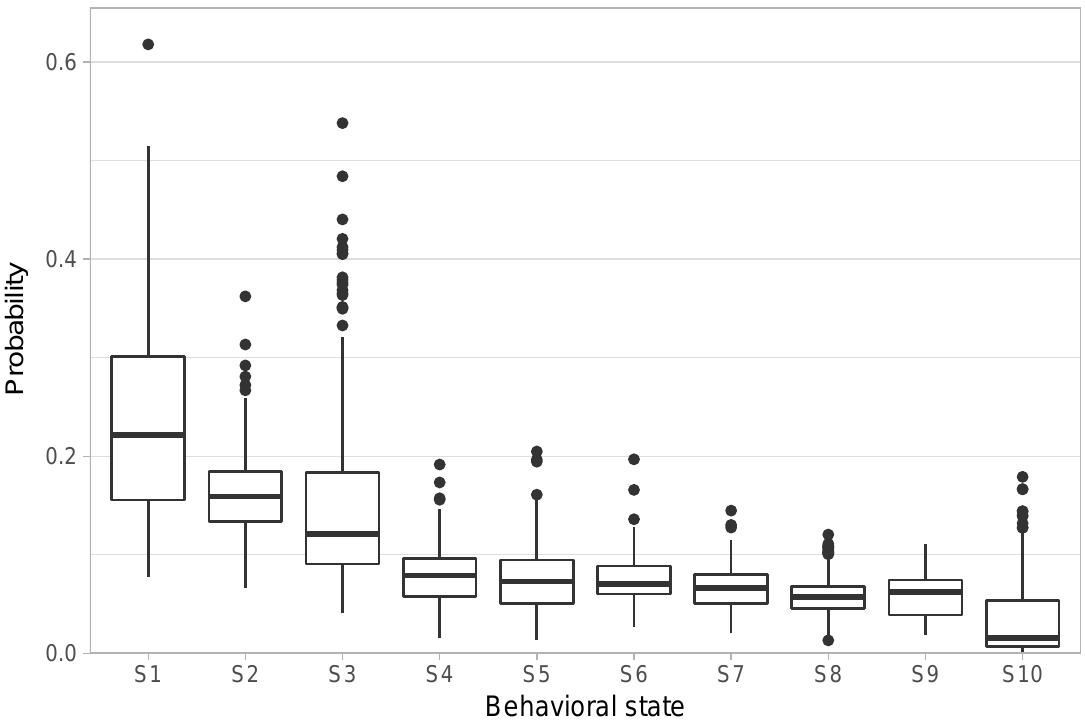
Figure 2. The distribution of phenotypes of the studied population. The box-and-whisker plots display the distribution of posterior mean probabilities of being in each state across all studied individuals. States are ordered by descending mean probability across the population. “Hinges” of the boxes represent 25%, 50%, and 75%